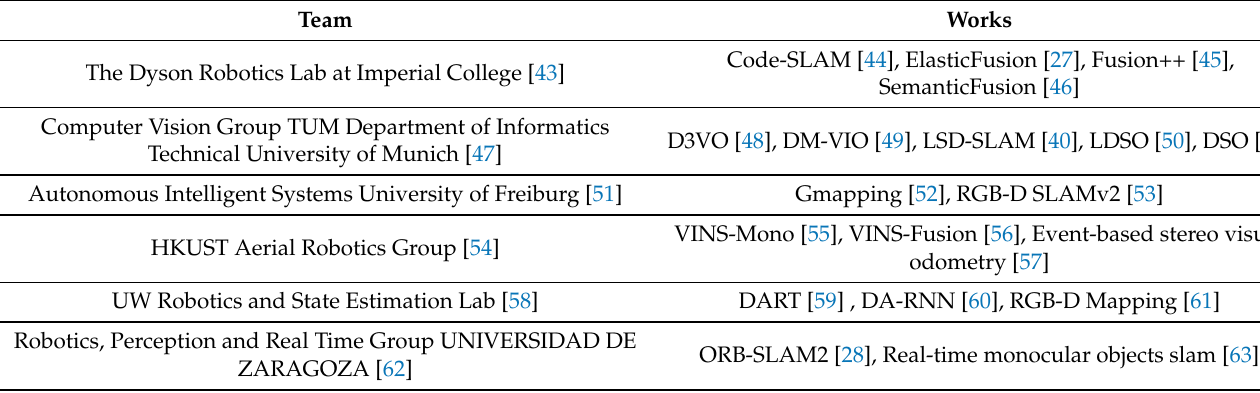
Table 2. Some great teams and their